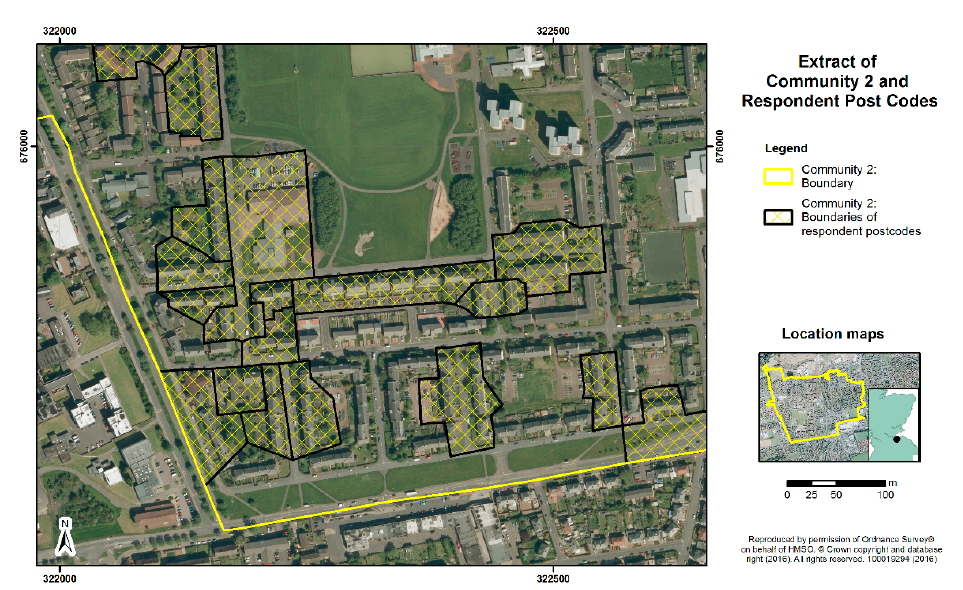
Figure 2. Aerial view of typical residential neighbourhood in Community 2.